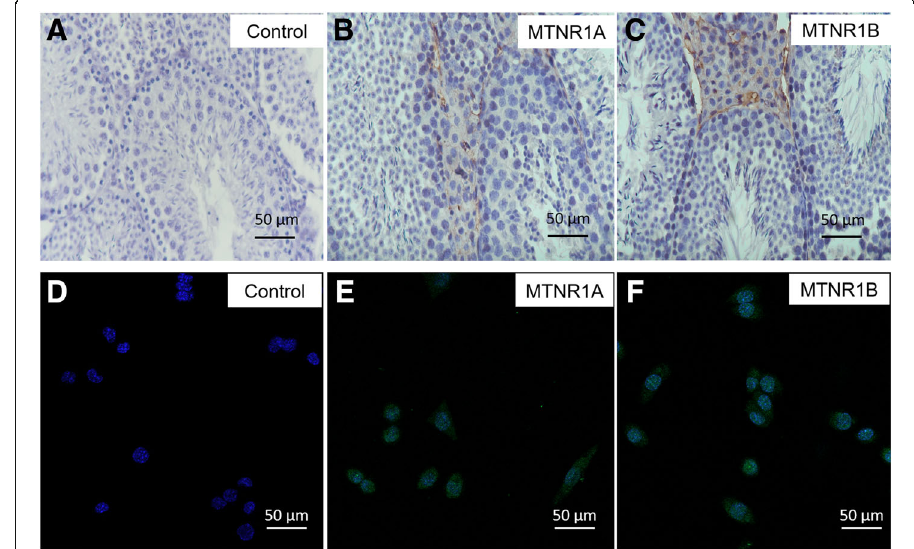
Fig. 1 Immunolocalization of MTNR1A and MTNR1B in mouse testes and mLTC-1 cells. a . Control staining was performed without primary antibody but PBS. b . Immunohistochemistry staining showed that MTNR1A was specially labeled in Leydig cell and Sertoli cells in mouse testes. c . Immunohistochemistry staining showed that MTNR1B was specially labeled in Leydig cells and Sertoli cells in mouse testes. d - f . Immunofluorescence staining using anti-MTNR1A and MTNR1B antibody and Alexa-Fluor 488 labeled secondary antibody showed that both MTNR1A and MTNR1B expressed specifically on cell membrane in mLTC-1 cells. Scale bar: 50 μ